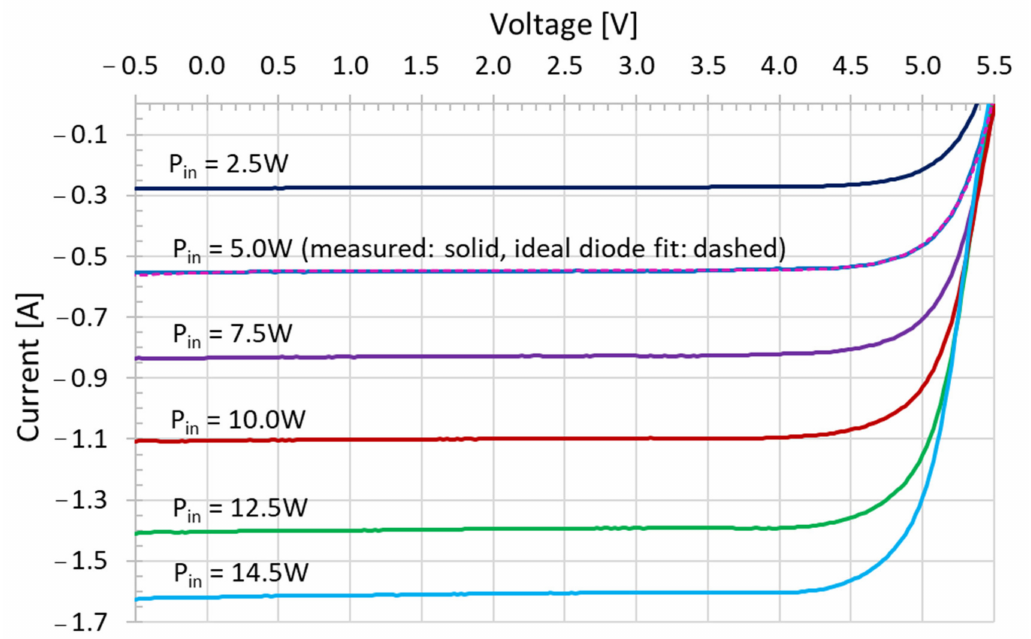
Figure 3. Measured I–V properties at 21 ◦ C for a PT10-InGaAs/InP OPC operating with a laser peaking at 1466 nm, for input powers between 2.5 W and 14.5 W. At 14.5 W of input power, an efficiency of Eff = 48.9% is obtained with a V oc of 5.46 V. The output power (P mpp ) reaches 7.09 W with V mpp = 4.675 V and I mpp = 1.517 A. The 5.0 W curve is also fitted with a 10J ideal diode model (pink dashed